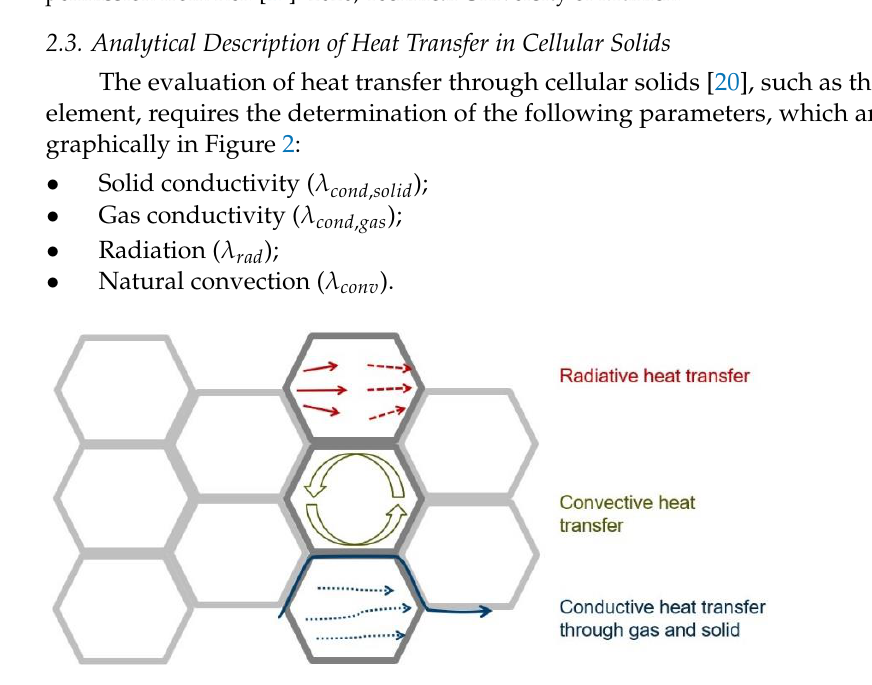
Figure 2. Heat transfer mechanisms in cellular structures, showing schematically radiative (red) and convective (green) heat transfer within the cells as well as conductive heat transfer (blue) through the gas (dotted line) and solid (continuous line).